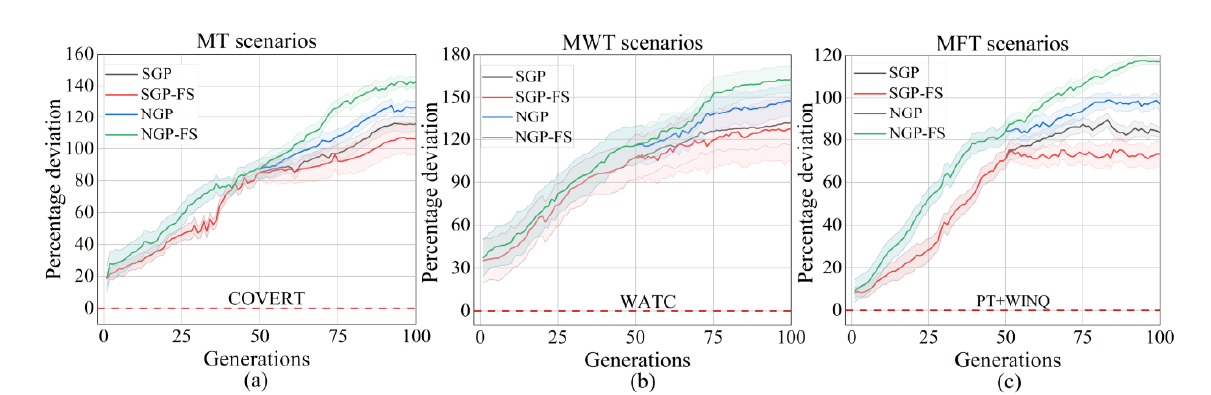
Figure 3. The percentage deviation of the GP algorithms for the three objectives in the training stage. ( a ): Percentage change in MT scenarios across generations, ( b ): Percentage change in MWT scenarios across generations, and ( c ): Percentage change in MFT scenarios across generations.